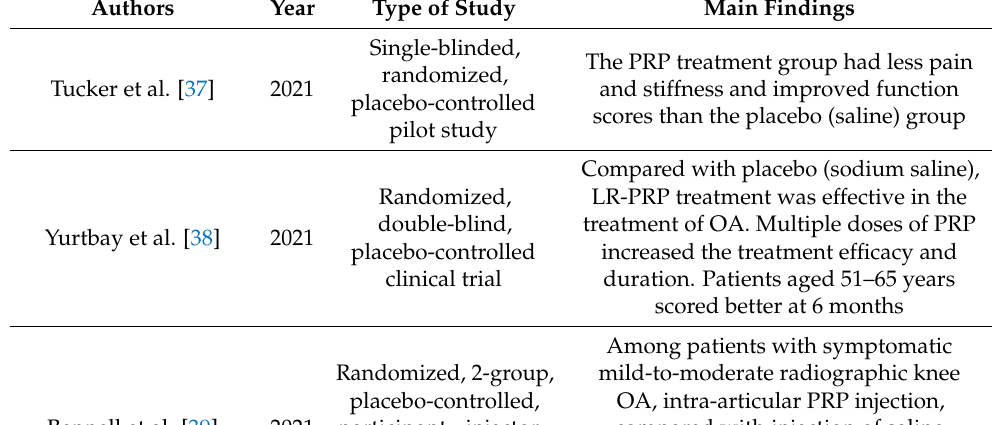
Table 2. Summary of the efficacy of intra-articular PRP injections in knee